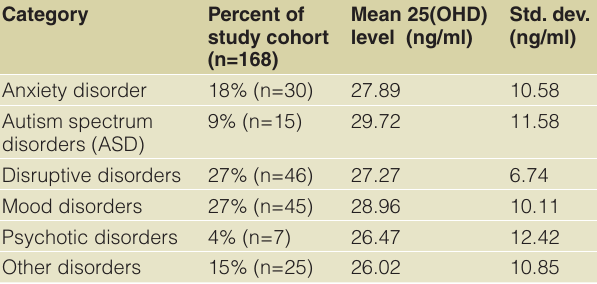
Table 2. Percent and mean 25(OH)D level by diagnostic categories.